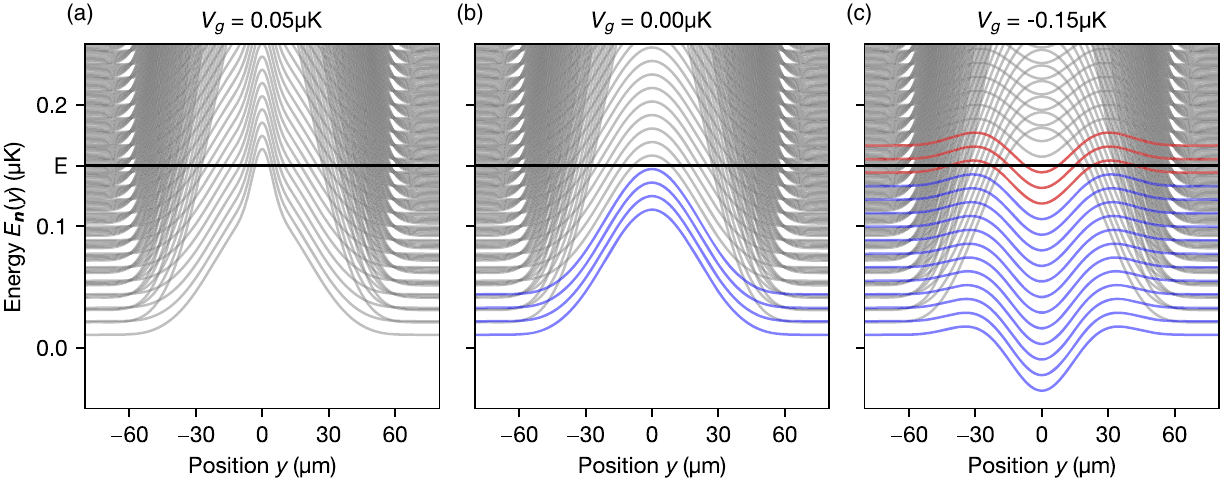
FIG. 8. Eigenenergies E n with transverse mode n versus longitudinal position y (a) with repulsive, (b) without and (c) with attractive gate potential V . Modes available throughout the channel at energy E (horizontal line) are indicated in blue and contribute to transport. g The ones in red are accessible close to the center but blocked away from it and the remaining modes are plotted in